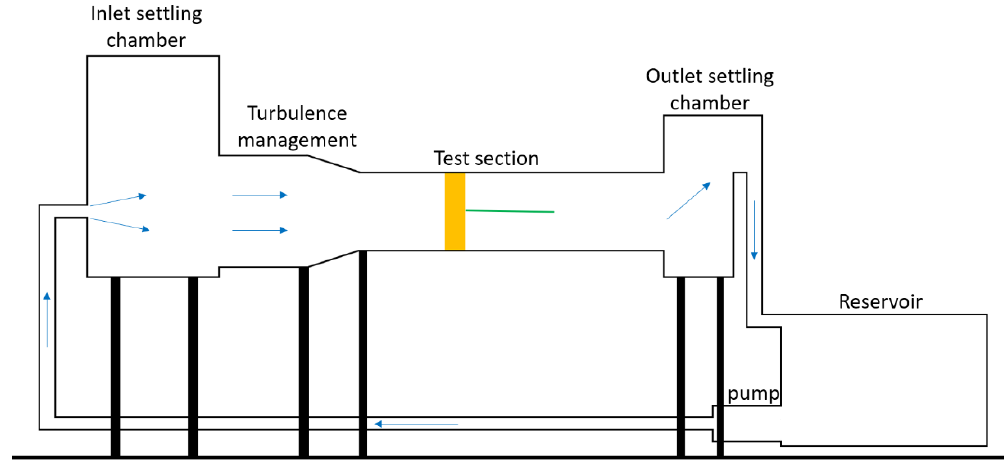
Figure 1. Schematic of experimental set-up for cylinder flow (test case). The brass cylinder and measurement plane are represented by a brass bar and green line respectively. Nominal flow direction is indicated with arrows.